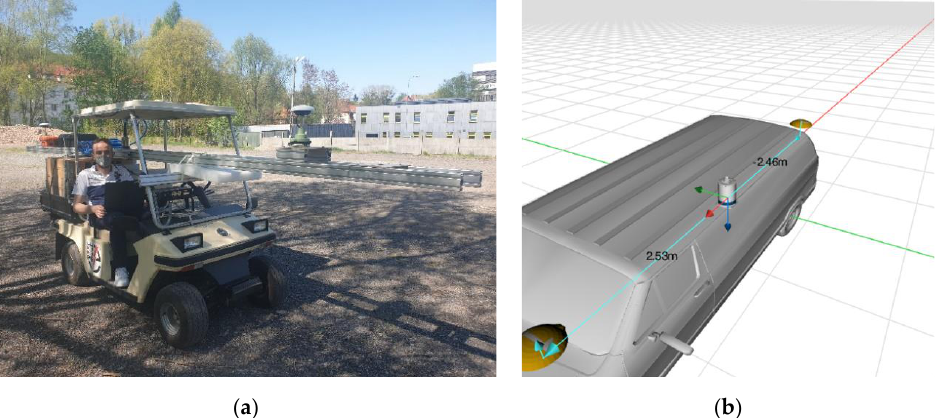
Figure 3. Melex electric vehicle used for the calibration of the GNSS/INS system ( a ) and the config- uration window for the Ekinox2-U system in the sbgCenter software ( b ).